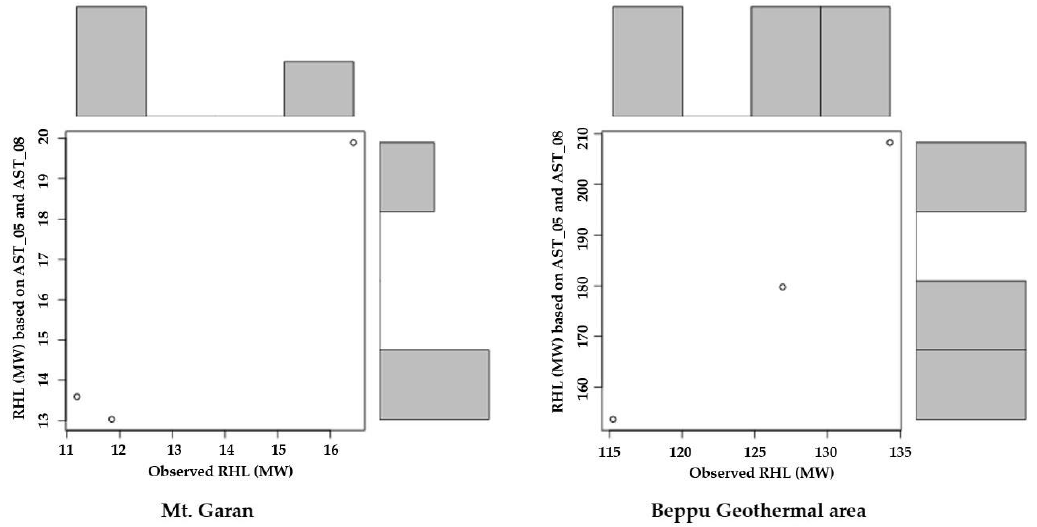
Figure 21. Scatter plots and histogram between observed and ASTER standard products base heat loss from the Mt. Garan fumaroles ( left ) and Beppu geothermal area ( right ).